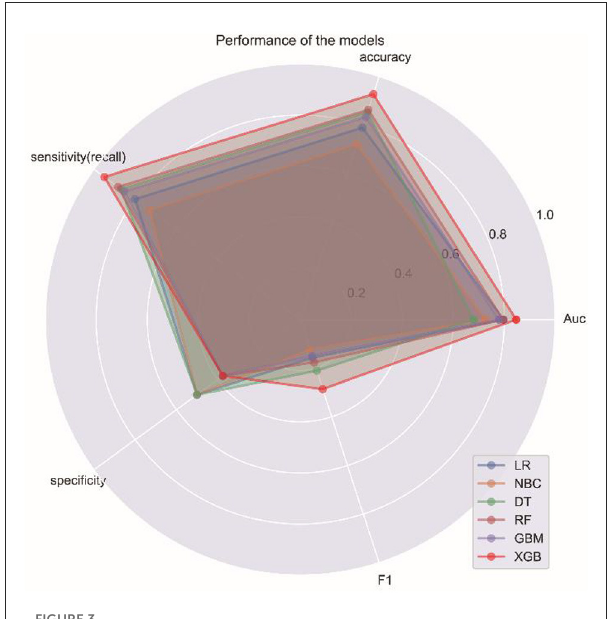
FIGURE3 Radar graph showing the comprehensive prediction performance of six ML algorithms.